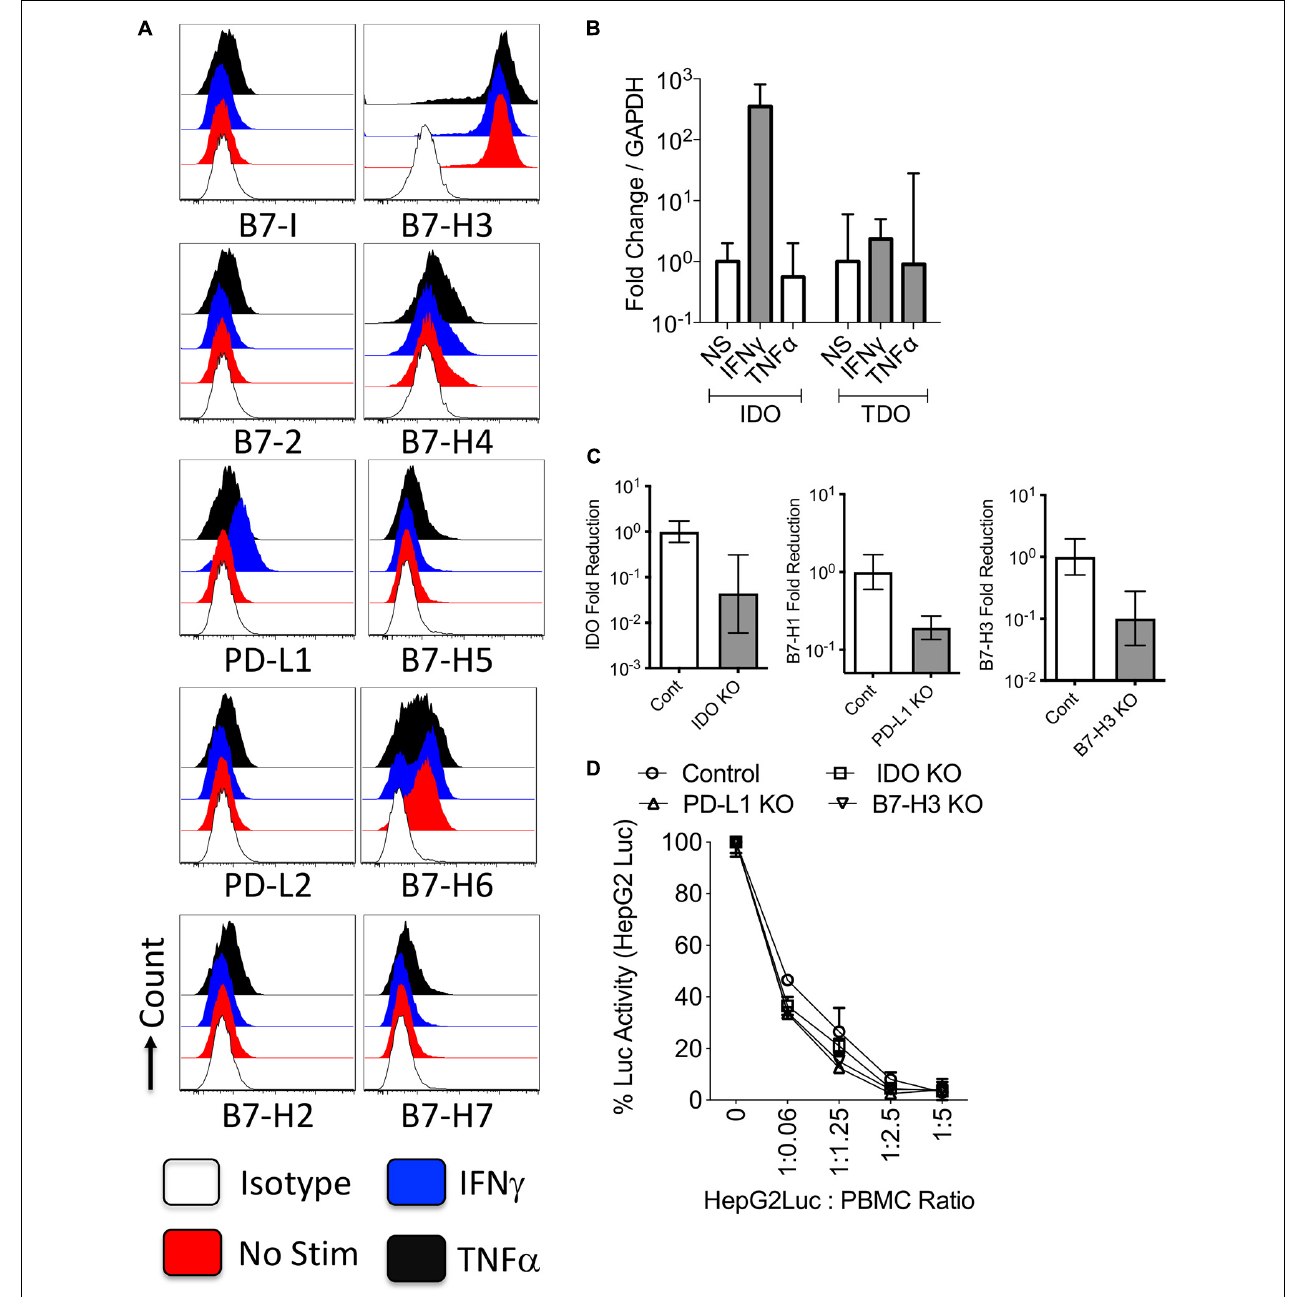
FIGURE 1 | Regulation and functions of B7 family ligands and tryptophan degrading enzymes in the hepatocellular carcinoma cell line. HepG2 cell lines were treated with IFN γ or TNF α and surface expressions of B7 family ligands were analyzed through flow cytometry. (A) Histogram analysis shows the expressions of B7 family ligands in HepG2 cells in response to IFN γ and TNF α . Appropriate isotype controls are included. (B) HepG2 cells were stimulated IFN γ and TNF α for 48 h. The RNA was extracted from the cells and the expression levels of IDO and TDO mRNA was quantitated by the quantitative SYBR green real time PCR. GAPDH mRNA levels were used as internal controls. Delta-delta CT method was applied to calculate the fold change. (C) Control or IDO or PD-L1 or B7-H3 siRNA transfected HepG2 cells were stimulated with IFN γ for 48–72 h. Expression level of IDO, PD-L1, and B7-H3 mRNA relative to GAPDH was evaluated by quantitative SYBR green real time PCR. Delta-delta CT method was applied to calculate the fold reduction. (D) IDO or PD-L1 or B7-H3 or control siRNA transfected HepG2-Luciferase cells were cultured with SEB stimulated PBMCs. After 3 days, luciferase activity was measured. Mean and standard deviation are shown from technical replicates. Representative results from two independent experiments are